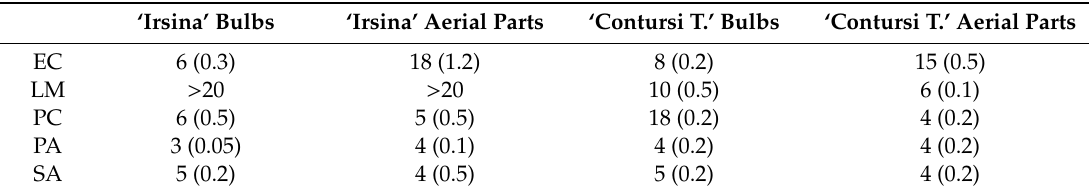
Minimal inhibitory concentration (mg / mL ± SD) exhibited by the extracts of aerial parts and bulbs of the two landraces of A. ampeloprasum against the pathogen strains E. coli (EC), L. monocytogenes (LM), P. carotovorum (PC), P. aeruginosa (PA) and S. aureus (SA). Data are the mean of three independent experiments. ‘Irsina’ Bulbs ‘Irsina’ Aerial Parts ‘Contursi T.’ Bulbs ‘Contursi T.’ Aerial